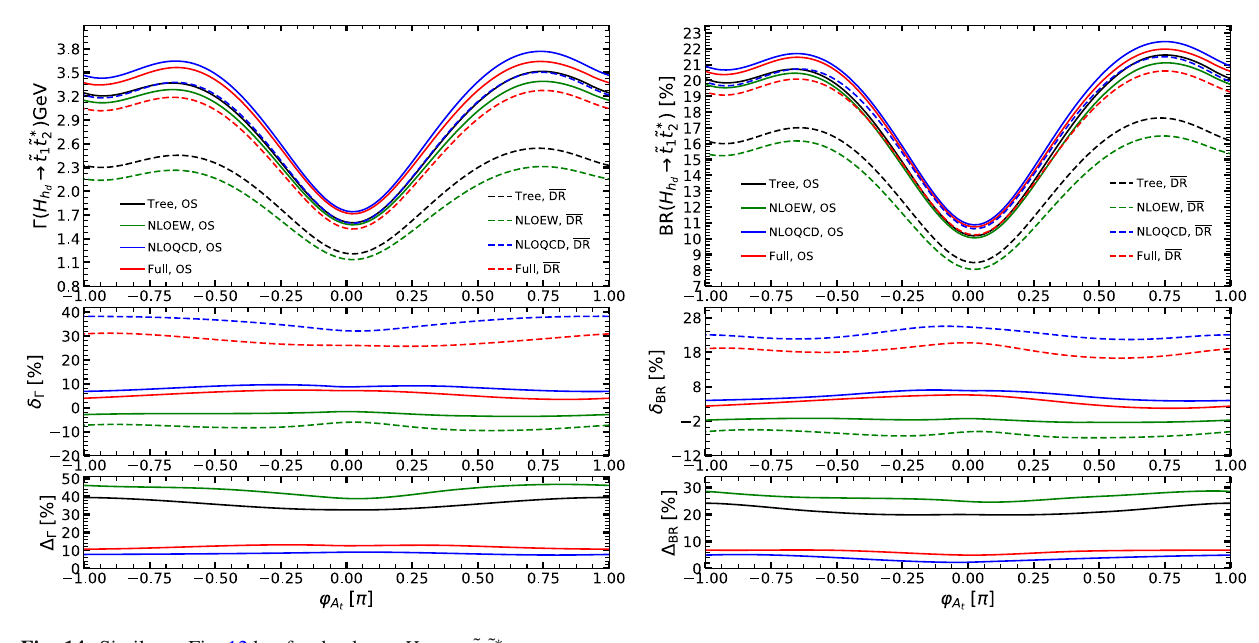
Fig. 14 Similar to Fig. 12 but for the decay H h